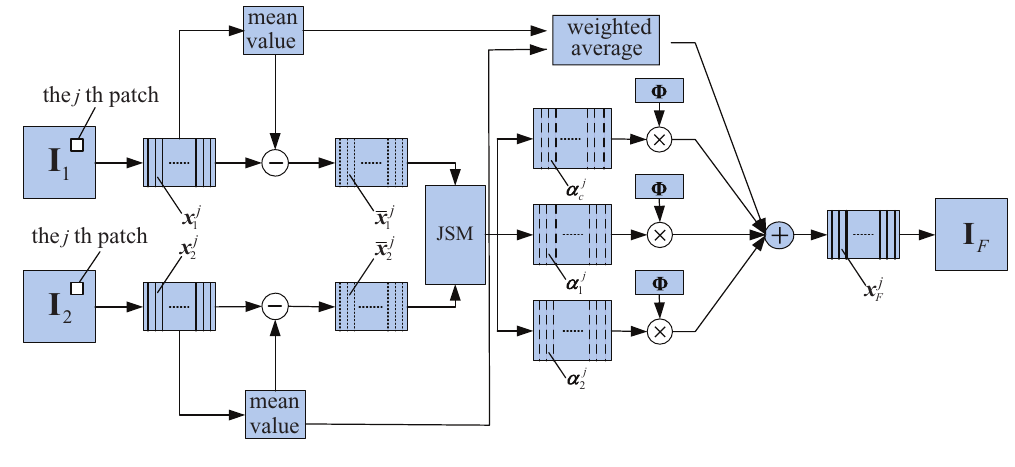
Figure 36. Diagram of the joint sparsity model (JSM)-based image fusion